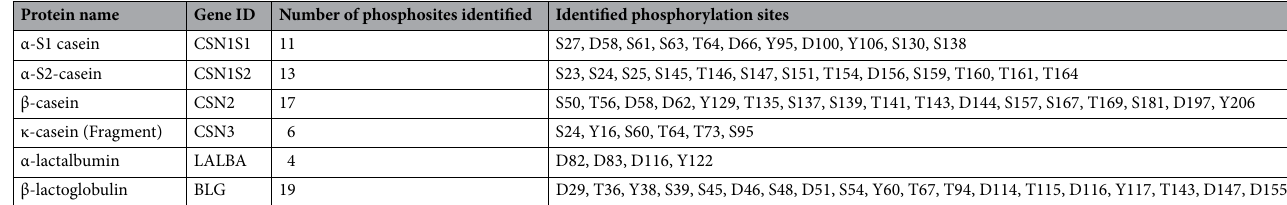
Table 1. Identified phosphosites for the major milk proteins in Capra hircus reference